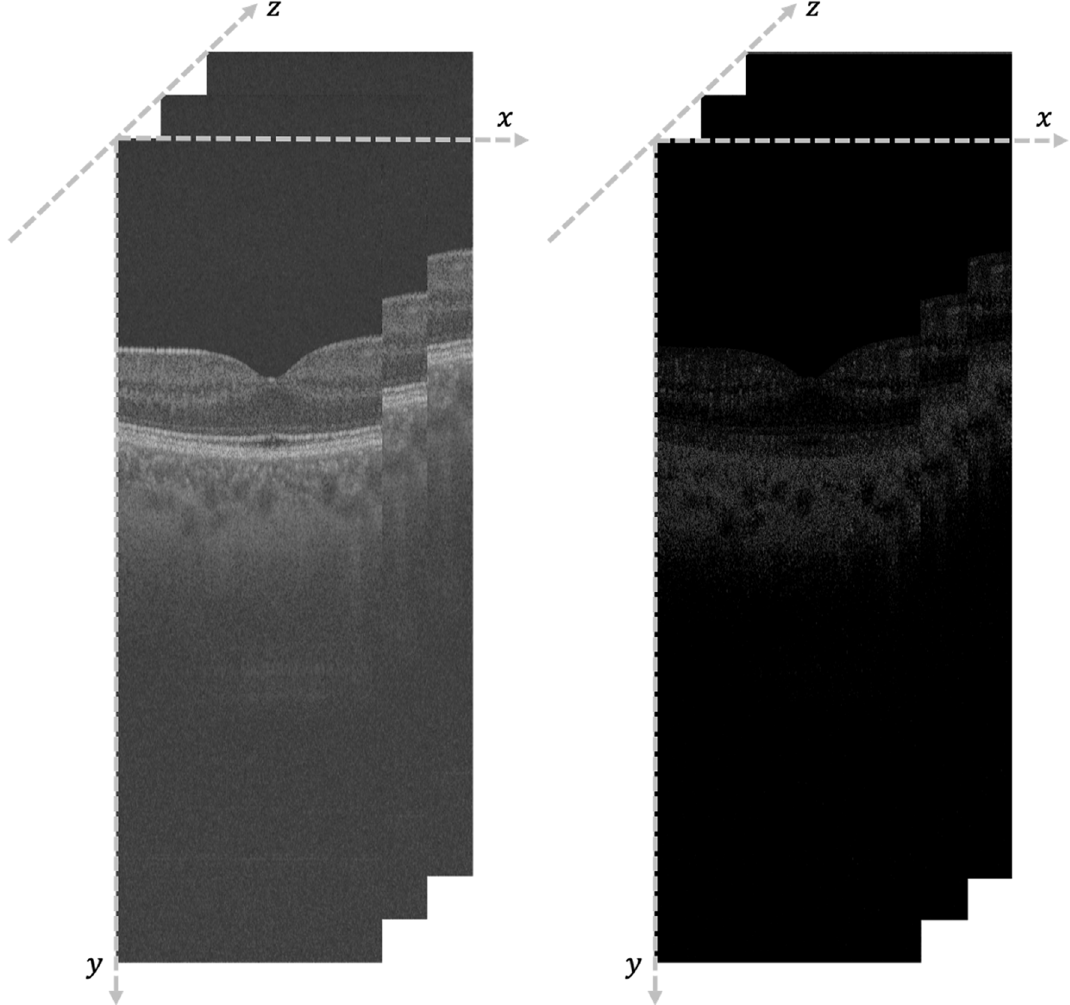
Figure 3. Illustrative case of the coordinate reference system and a visual example of corresponding slices from OCT scan and OCT flow.